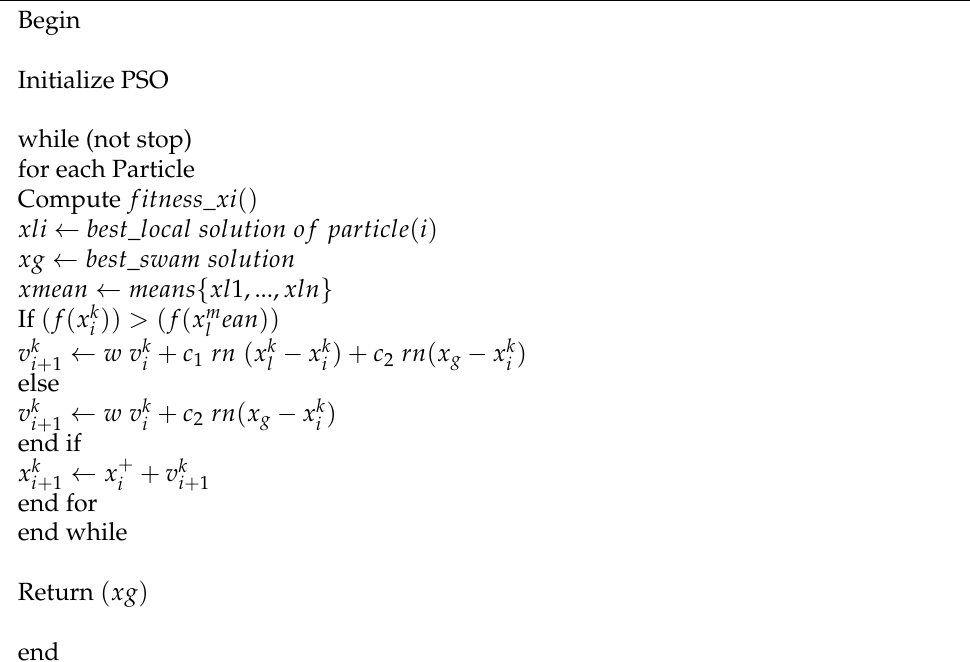
Algorithm 1 The simplified pseudocode of the